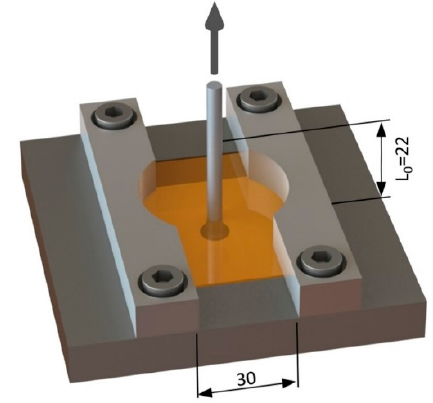
Figure 4. T-Pull testing set-up schematic representation (dimensions in millimeters).